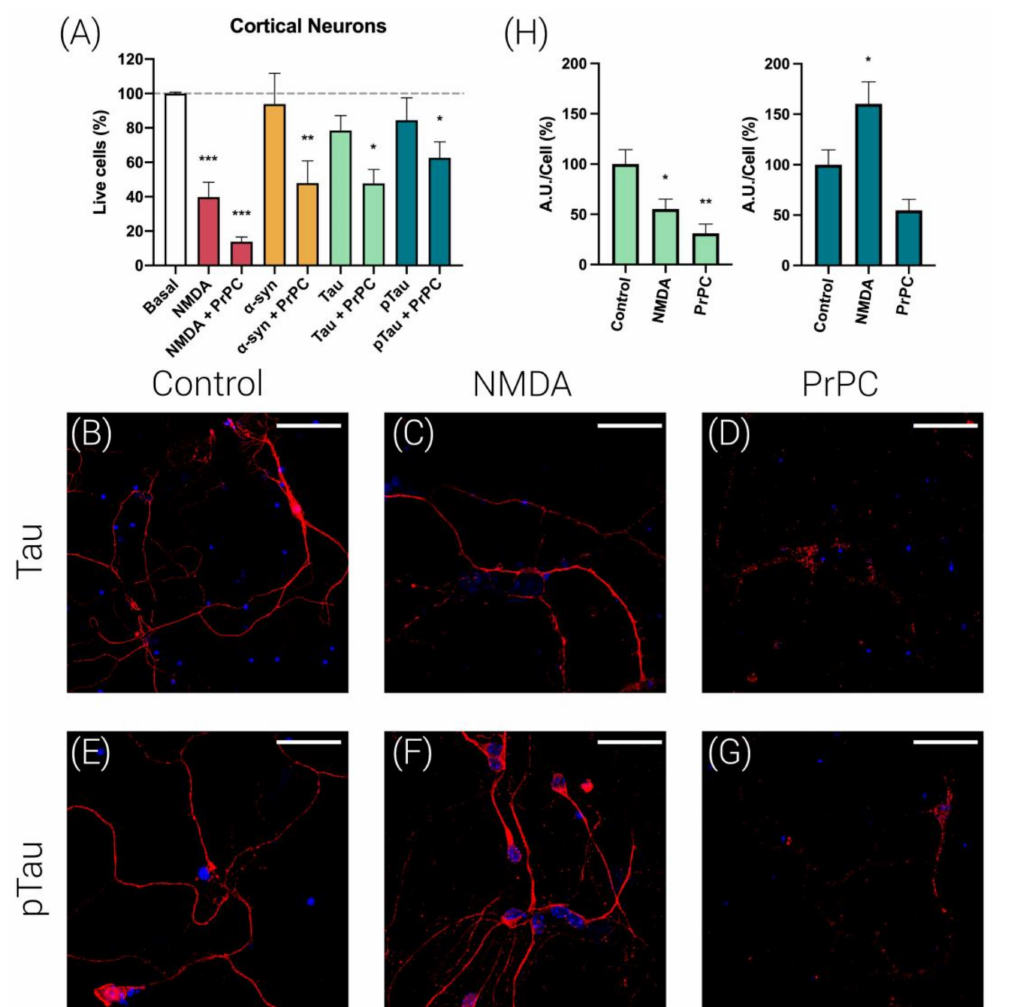
Figure 2. Cell viability assays and Tau and pTau immunolabeling in primary neurons. ( A ) Cortical neurons were transfected or not with the cDNA for the human PrPC protein (1 µ g) and subsequently treated with NMDA (15 µ M, red), alpha-synuclein (4 µ M, orange), Tau (1 µ M, green) or pTau (1 µ M, dark green) for 4 h. For quantification of living cells, cortical neurons were mixed with an equal volume of trypan blue (0.4%). Bar graph shows live cells (colorless cells/total cells × 100, %) in comparison with basal (untreated cells). Values are the mean ± S.E.M. of 5 independent experiments performed in triplicate. One-way ANOVA followed by Bonferroni’s multiple comparison post hoc test was used for statistical analysis (* p < 0.05, ** p < 0.01, *** p < 0.001 versus basal condition). ANOVA summary: ( A ) F: 8.70 p < 0.001. Immunocytochemistry assays were performed in hippocampal primary neurons to detect Tau ( B – D ) and pTau proteins ( E – G ). Bar graph shows quantification of the amount of fluorescence (Arbitrary Units, A.U.)/cell (%) in comparison with control cells for Tau (green bars) or pTau (dark green bars) ( H ). Values are the mean ± S.E.M. of 5 independent experiments performed in triplicate. One-way ANOVA followed by Bonferroni’s multiple comparison post hoc test was used for statistical analysis (* p < 0.05, ** p < 0.01 versus basal condition). ANOVA summary: ( H ) (left) F: 8.41 p < 0.003. (right) F: 7.88 p < 0.003. Tau protein was detected by an anti-Tau rabbit monoclonal antibody and a secondary Cy3-conjugated anti-rabbit IgG antibody (red). pTau protein was detected by an anti-pTau (S396) rabbit monoclonal antibody and a secondary Cy3-conjugated anti-rabbit IgG antibody (red). Neurons were treated with NMDA (15 µ M) ( C , F ) or were transfected with the cDNA for the human PrNP (1 µ g) ( D , G ). Cell nuclei were stained with Hoechst (blue). Scale bar: 20 µ